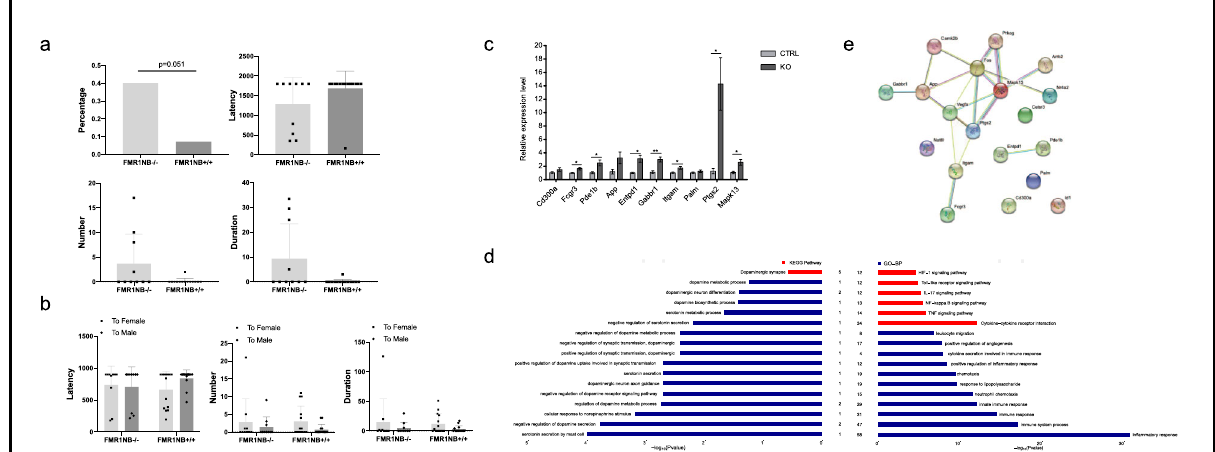
Fig. 4 Animal sexual behavior and transcriptomics associated with the FMR1NB gene. a The mounting behavior of FMR1NB − / − ( n = 10) and FMR1NB + / + ( n = 14) male mice in resident-intruder tests: The percentage of males who mounted target males was higher in FMR1NB − / − males than FMR1NB + / + males. The difference was very nearly signi fi cant ( P = 0.051). FMR1NB − / − male mice mounted with a tendency for a higher frequency ( P = 0.092) and longer duration ( P = 0.071); Sexual preference of FMR1NB + / + and FMR1NB − / − male mice in the mating choice assay. b The mounting latency, number and duration toward females in FMR1NB + / + and FMR1NB − / − male mice are shown. c Relative expression level of DEGs. d Altered GO and KEGG pathways of serotonin, dopamine (left) and representative in fl ammatory (right) DEGs. e Protein-Protein Interaction (PPI) Network of